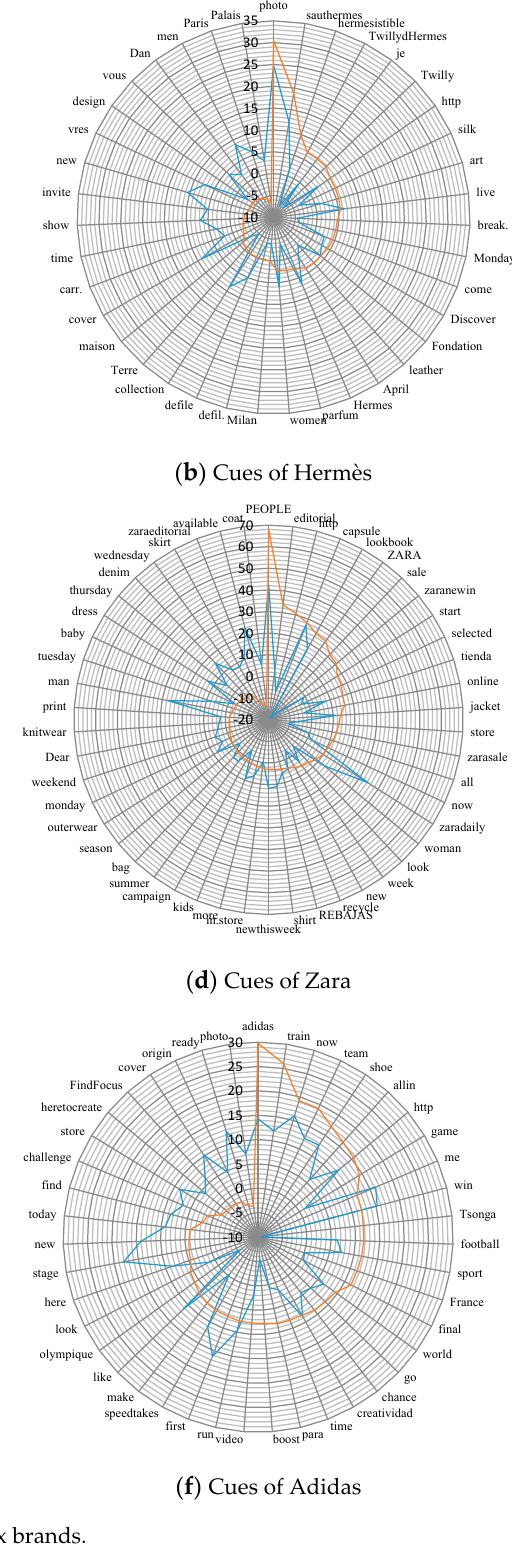
Figure 3. Cues of six brands.